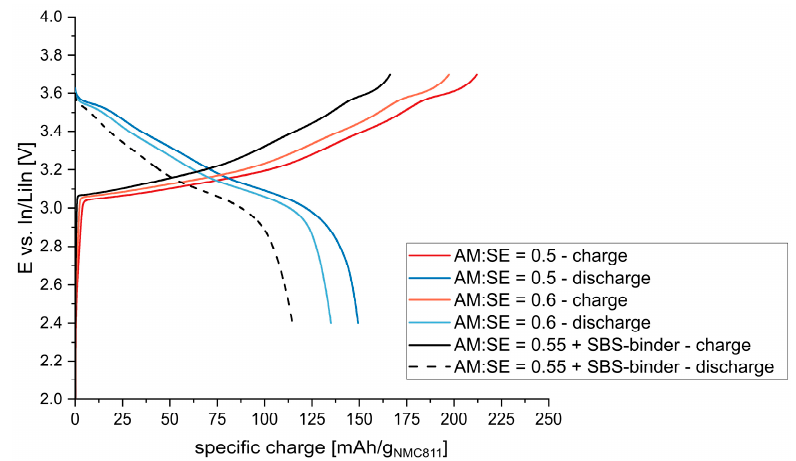
Figure 7. Potential profile of a cast composite cathode is compared with the profiles of two powder cathodes.